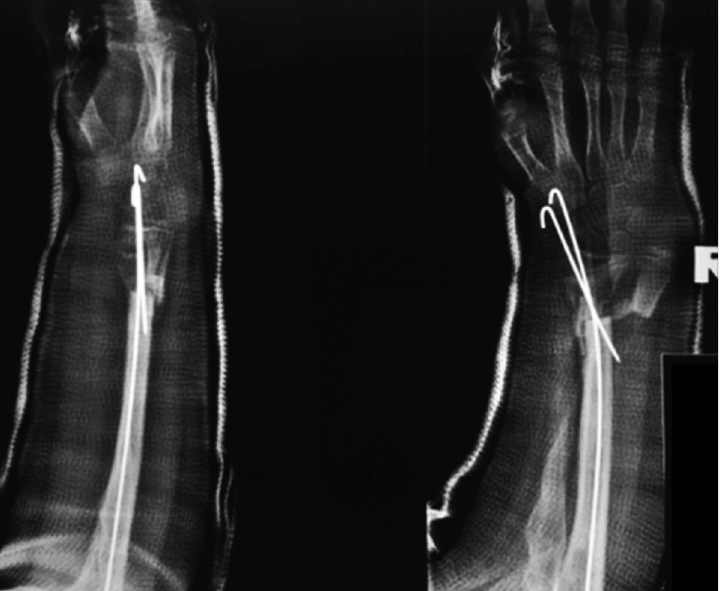
Immediate post-operative radiographs of the Fig. 2: